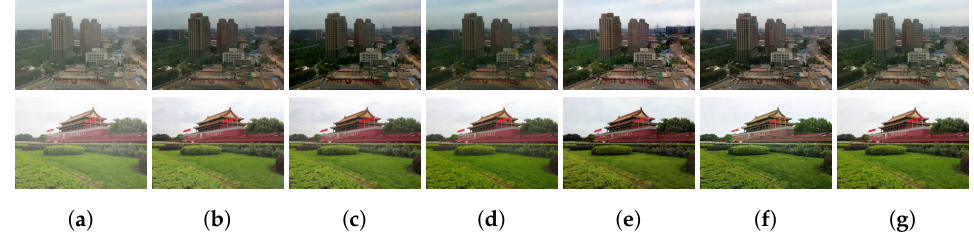
Figure 7. Qualitative comparison of defogging on two sample images extracted from the HSTS synthetic test set [9]. ( a ) Foggy images, ( b ) defogging by CAP [23], ( c ) defogging by DehazeNet [2], ( d ) defogging by AOD-Net [4], ( e ) pix2pix [34], ( f ) CurL-Defog (our method), and ( g ) ground-truth images. Images are better viewed if enlarged on a computer